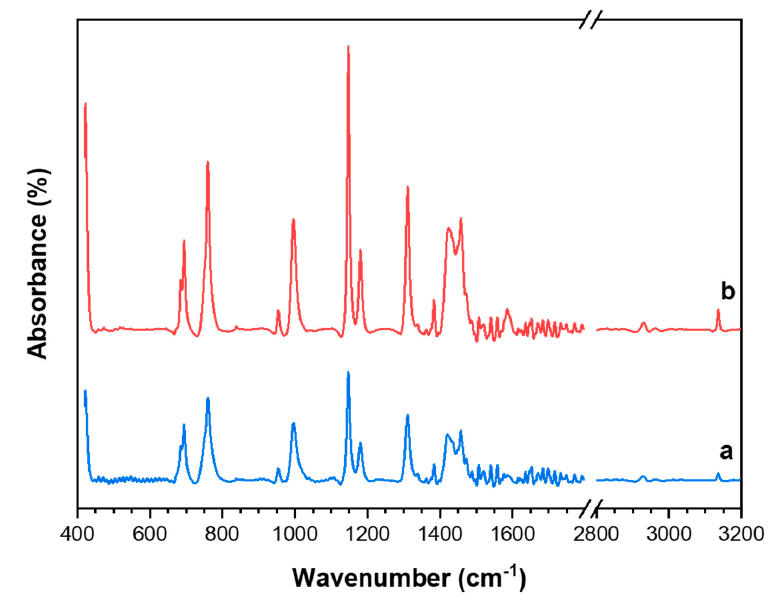
Figure 2. The FTIR spectra of ( a ) ZIF-8 and ( b ) ZIF-8-HT.